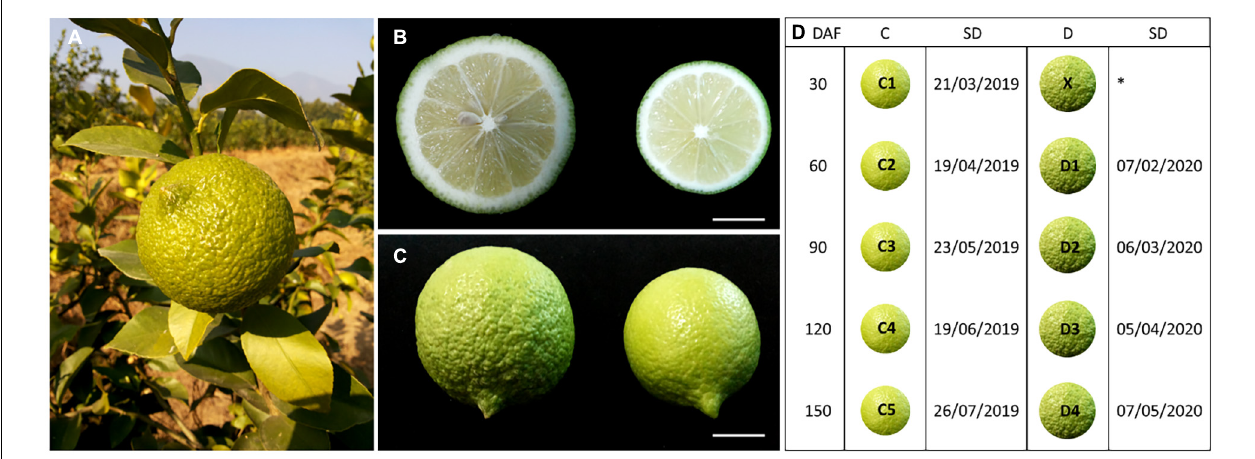
FIGURE 1 | (A) Large fruit with thick skin, (B) Comparison of (left) rough- and (right) smooth- skinned lemon fruits (cut), (C) whole fruit, and (D) information on the sampling dates for C; control and D) representation of the experimental fruit groups. The circular images are representations of the fruit peels and do not reflect the size based on different DAF. DAF, days after flowering; SD, sampling date. ∗ indicates that fruit samples were not collected because of the seasonal effect. Scale bar = 1 cm.